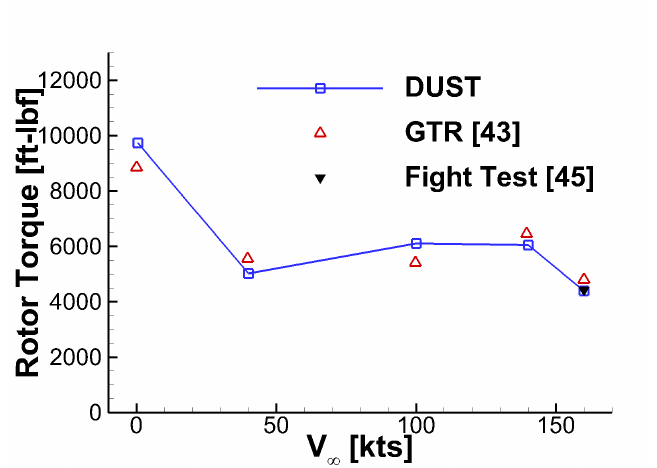
Figure 7. Comparison of the proprotor torque computed by DUST with GTR [46] and flight test data.